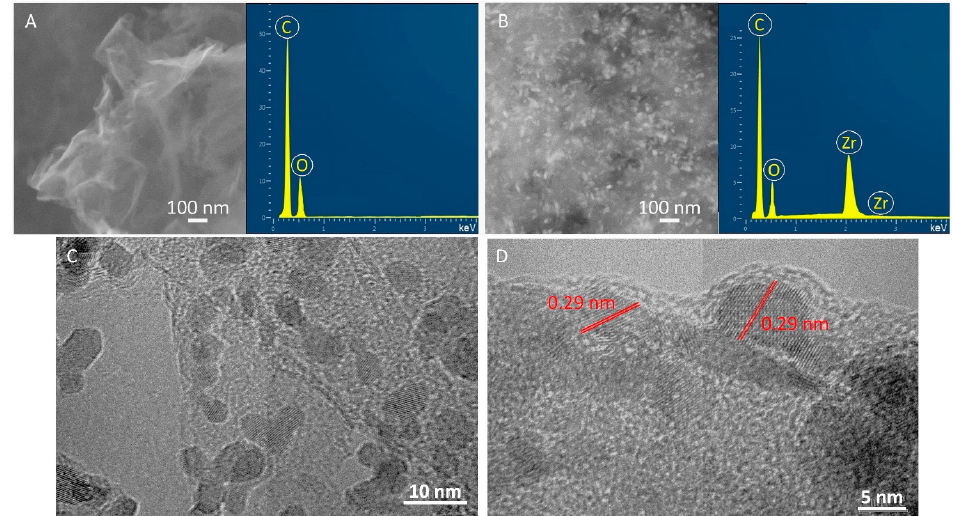
Figure 5. SEM images and EDS spectra of GO ( A ) and hydrothermally synthesized ZrO 2 / rGO nanocomposite powder ( B ). Representative TEM ( C ) and HRTEM ( D ) images of ZrO 2 / rGO nanocomposite powder.